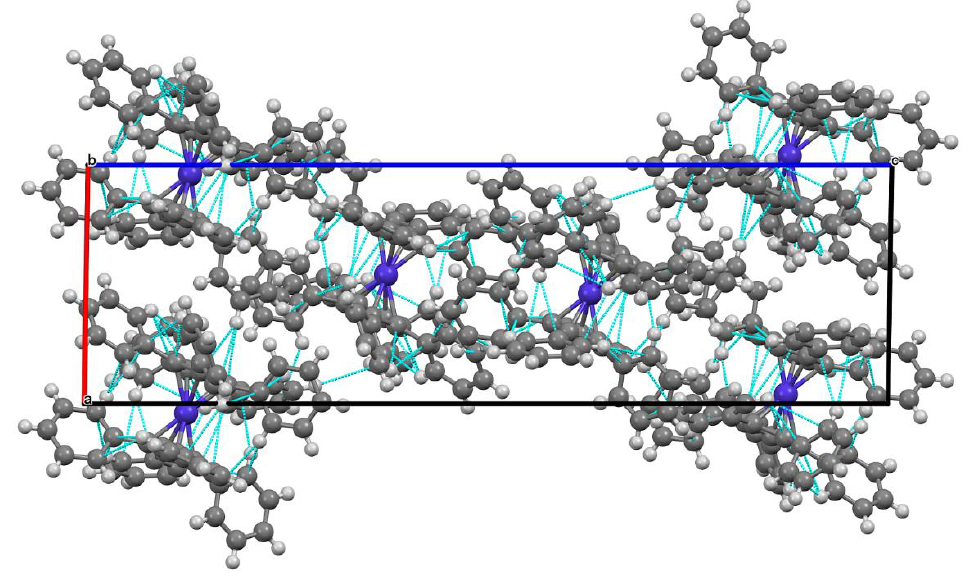
Figure 3. Packing plot of 1 along the b axis. The light blue lines show the intra- and intermolecular C–H...C interactions (van der Waals distance (H...C) between the sum of radii rH + rC minus 5.00 and 0.0 Å; “intra” distances for atoms separated by more than 3